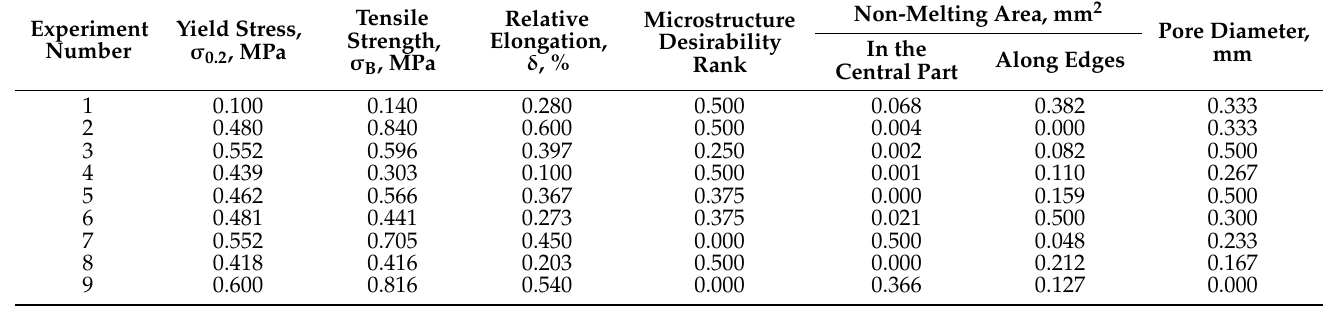
Table 8. The values of the gray relational coefficient ξ ij .